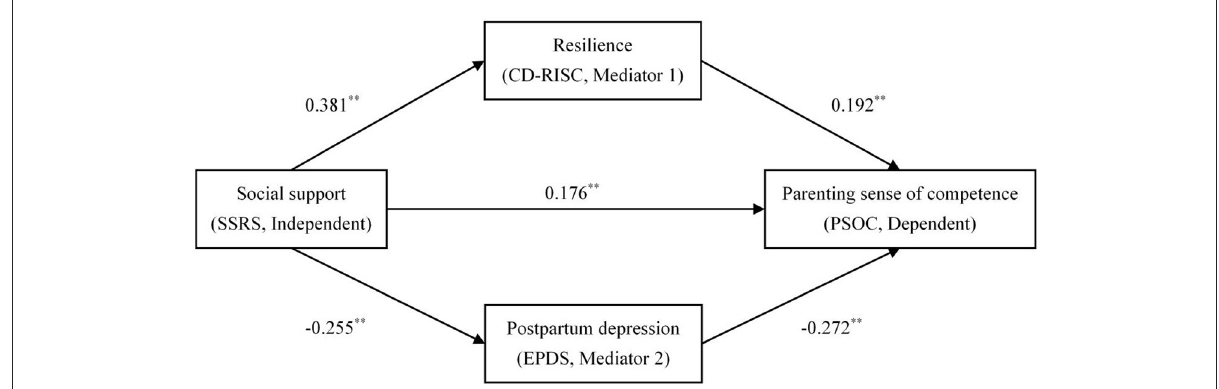
FIGURE2 Multiple mediating paths between social support and parenting sense of competence. ** p <